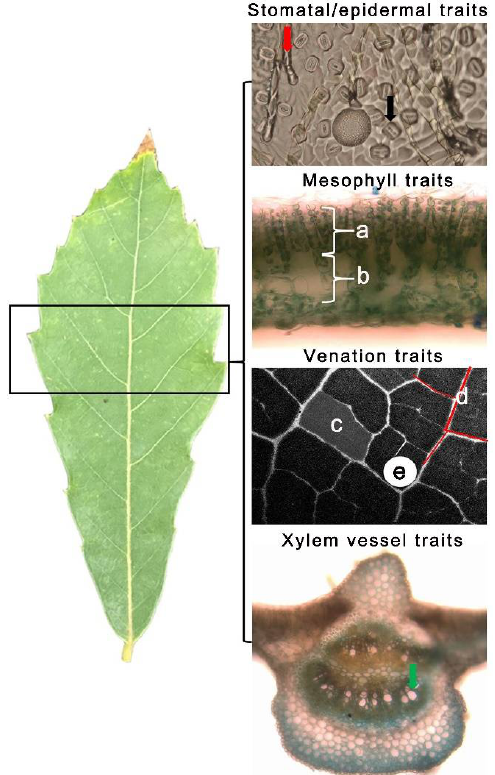
Figure 11. The schematic diagram for the measurement of the stomatal density (black arrow), trichome density (red arrow), mesophyll traits showing (a) palisade tissue and (b) spongy tissue, venation traits showing (c) loopiness, i.e., number of closed loops in the FOV divided by the FOV area, (d) vein density, i.e., the total length of veins in the FOV divided by the FOV area, (e) vein distance, i.e., the mean diameter of the largest circular masks that can fit in a closed loop, and xylem vessels (green arrow) [53] measured in the leaves of Quercus acutissima and Q. serrata . For the measurement of venation traits, ten leaves were collected from each treatment and species and were also subjected to a dehydration series using ethanol from 30% to 100% concentrations. We did not skeletonize the leaves because the midrib and second- and third-order veins were already visible after the last stage of the dehydration series. The vein density (mm mm −2 ), vein distance (mm), and vein loopiness (count mm −2 ) were measured in each leaf sample, as shown in Figure 11 [53]. In all microscopic examinations, five fields of view (FOV) at ×400 magnification were photographed from each sample. The values obtained from the FOVs were averaged for each leaf sample, and the average values of ten leaves were recorded for each species. 4.4. Leaf Gas Exchange Measurement From each treatment and species, ten seedlings were selected for leaf gas exchange measurement, which was carried out between 9:00 am and 12:00 pm. Sun-exposed, healthy, and fully expanded leaves attached to an orthotropic branch (5th — 6th nodes from the apical bud) of the seedlings were used in the study. The measurement was done only in still-green leaves as older leaves, which were produced before treatment imposition, were already starting to wilt as early as the 5th week of the experiment (Supplementary Materials, Figure S1). The stomatal conductance (g s , mol H 2 O m −2 s −1 ) and transpiration (E, mmol H 2 O m −2 s −1 ) were measured using a portable gas exchange measuring system (LI- 6400XT, LI-COR Inc., Lincoln, UK). The water use efficiency (WUE, µmol CO 2 m −2 s −1 per